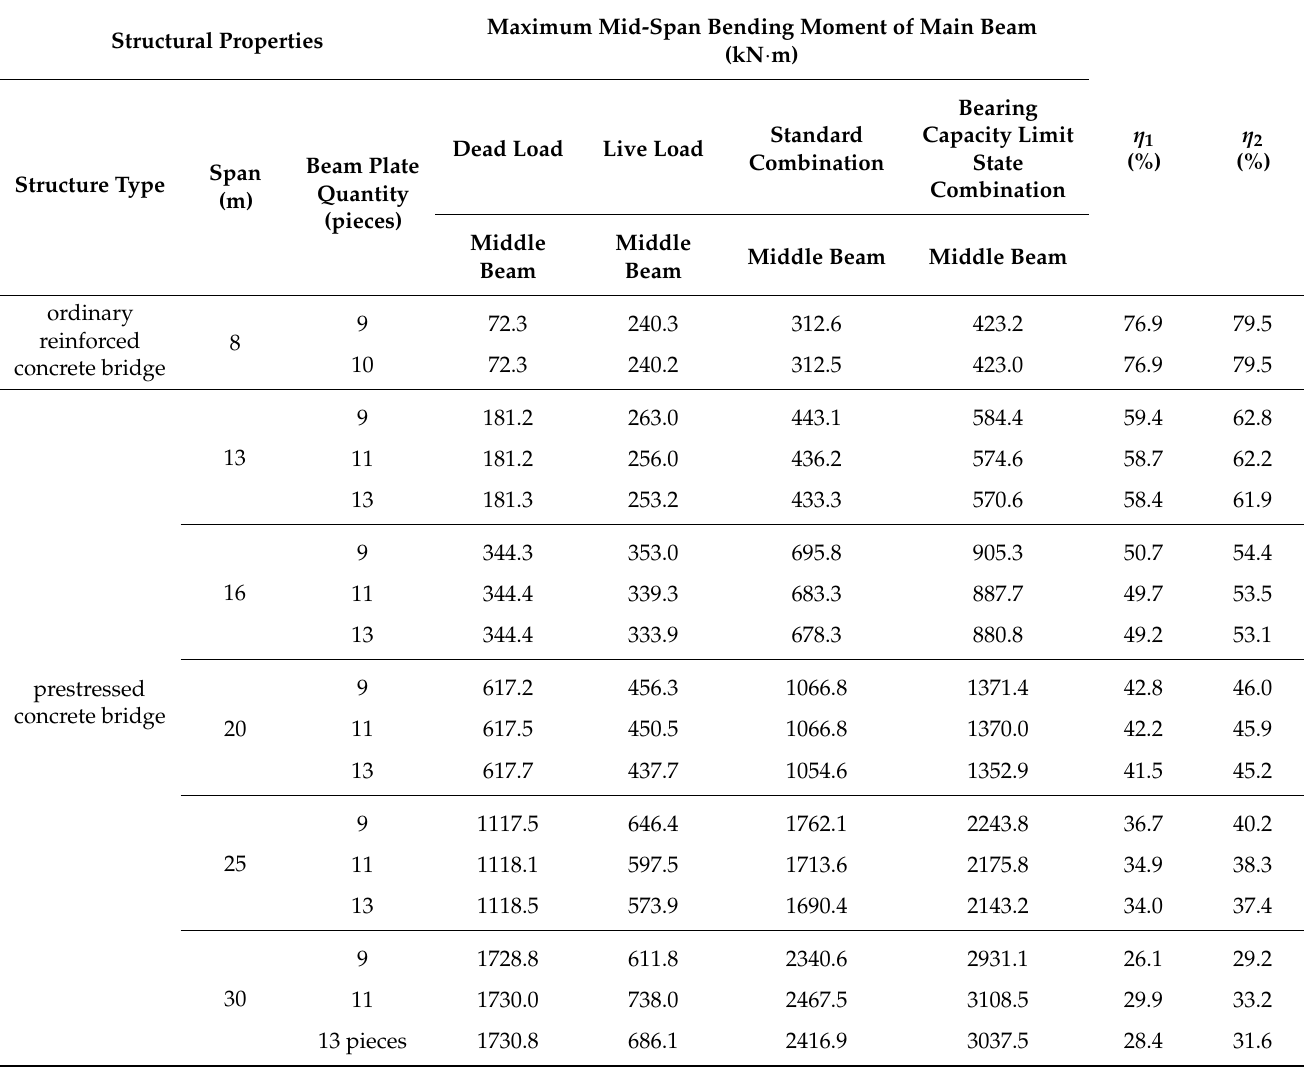
Table 3. The constant live load ratio of common short and medium bridges on Pingli